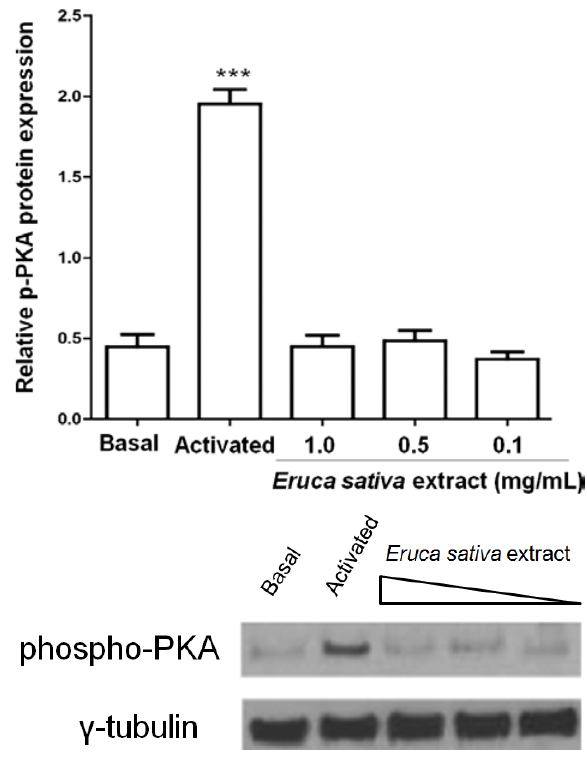
Figure 4. Effect of Eruca sativa Mill. extract on phospho-PKA in activated platelets by ADP (8 μmol/L). The activated group corresponds to prostaglandin E 1 (PGE 1 ) plus ADP. Data are presented as the mean ± SEM of n = 6 experiments. *** p < 0.001 indicates the difference between activated and basal groups as analyzed by one-way ANOVA and Tukey’s post hoc